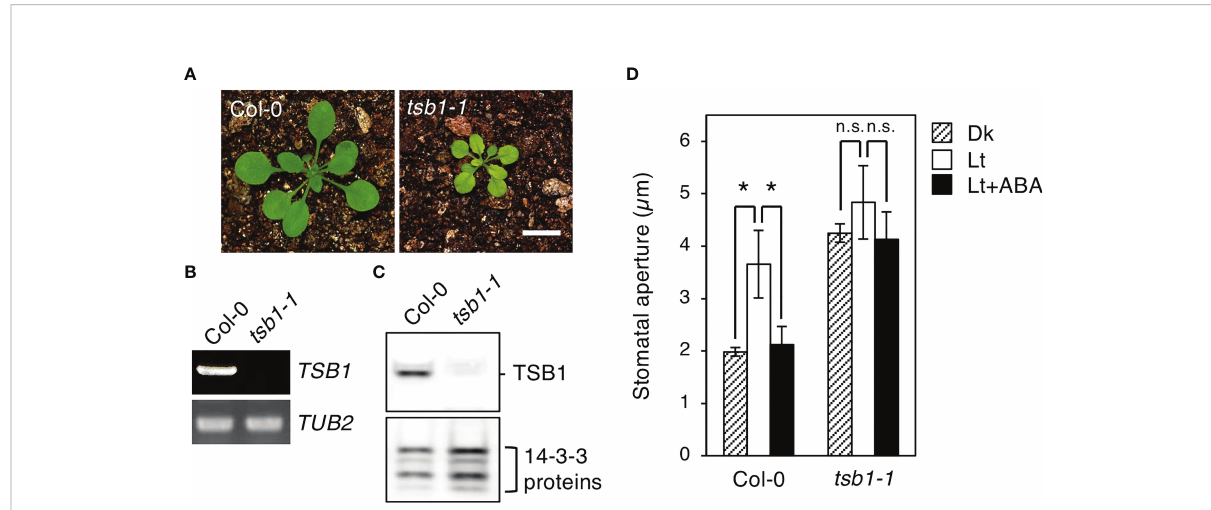
FIGURE 3 Phenotypic analysis of a TSB1 knockout mutant, tsb1-1 . (A) Five-week-old Col-0 and tsb1-1 plants. Plants were grown on MS plate for 4 weeks and transferred to soil for 1 week. Scale bar = 1 cm. (B) TSB1 expression analyzed by RT-PCR in Col-0 and tsb1-1 . Other details are the same as in Figure 2C. (C) Immunoblot analysis of TSB1 protein in Col-0 and tsb1-1 . Other details are the same as in Figure 2D. (D) Stomatal aperture of Col-0 and tsb1-1 plants. Other details are the same as in Figure 1D. Values represent mean ± SD (n = 3); measurement of 35 stomata in each experiment. Asterisks indicate a signi fi cant difference by Student t test; * P < 0.05. n.s., not signi fi